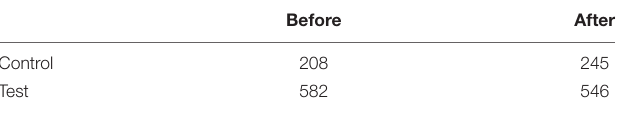
TABLE 1 | Overview of survey respondents.